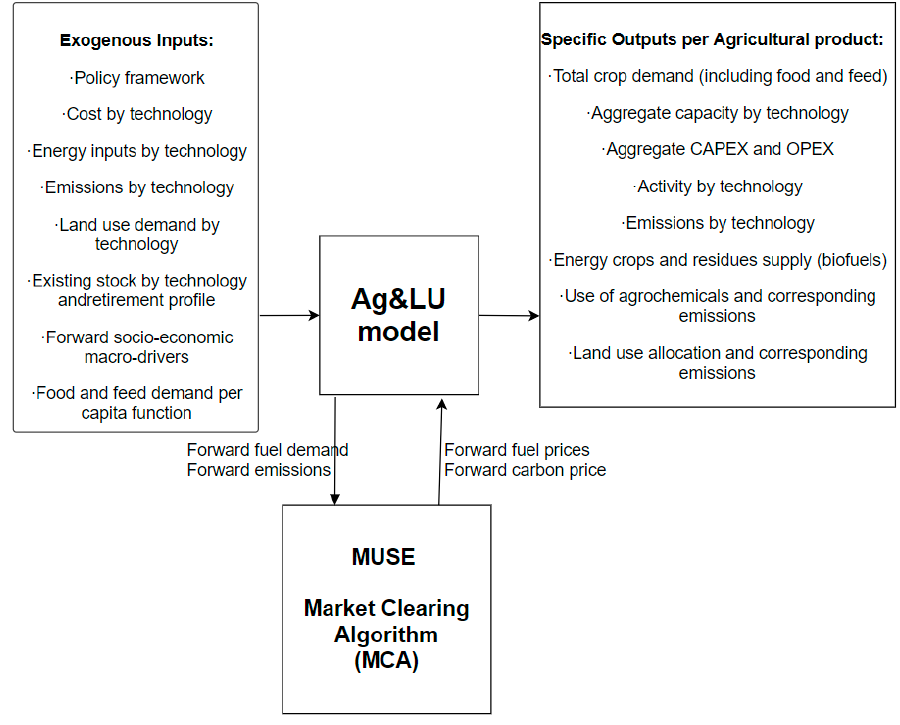
Figure 2. MUSE-Ag & LU framework and data exchange. Source: [59].